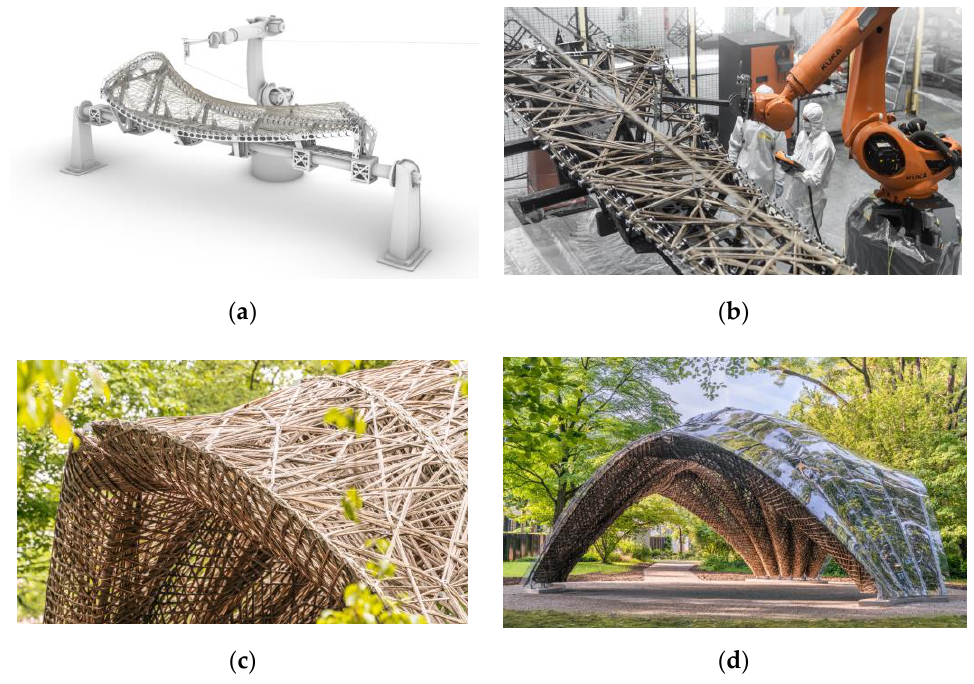
Figure 1. First large-scale application of natural fibers in a coreless wound structure, the LivMatS pavilion [24]. ( a ) Digital planning of the winding setup and process; ( b ) state-of-the-art multi-axis robotic fabrication setup using a stationary resin bath impregnation method and an external creel; ( c ) natural fiber component (flax and sisal mix) during building erection; ( d ) final pavilion. © ICD/ITKE/IntCDC University of Stuttgart.